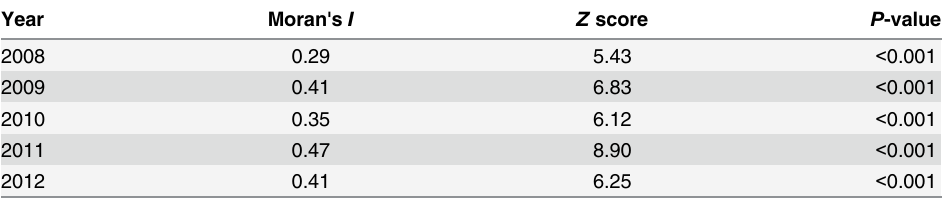
Table 4. The Moran ’ s I of global spatial autocorrelation analysis for mild cases of HFMD during 2008 –